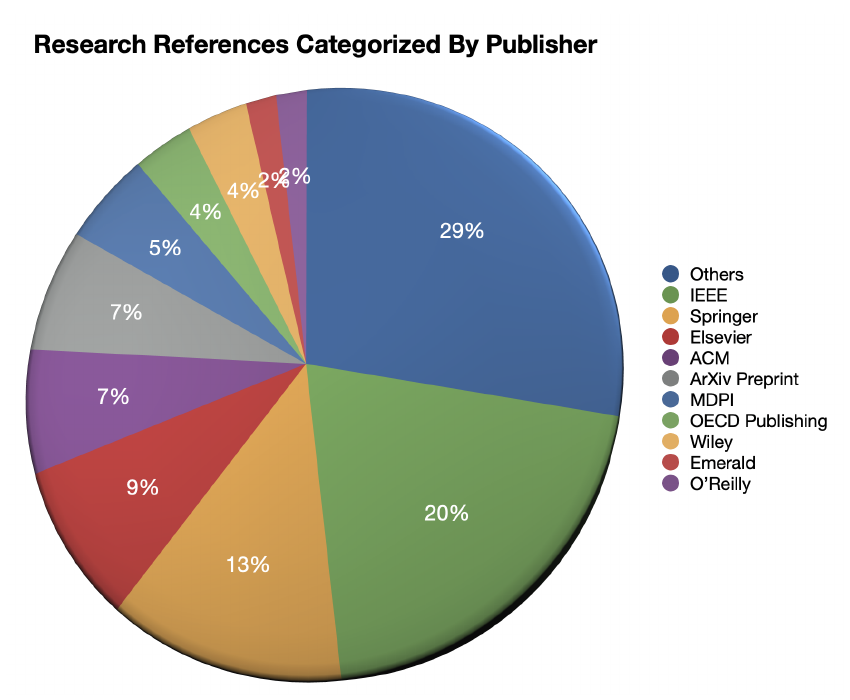
Figure A2. Research references by publisher.